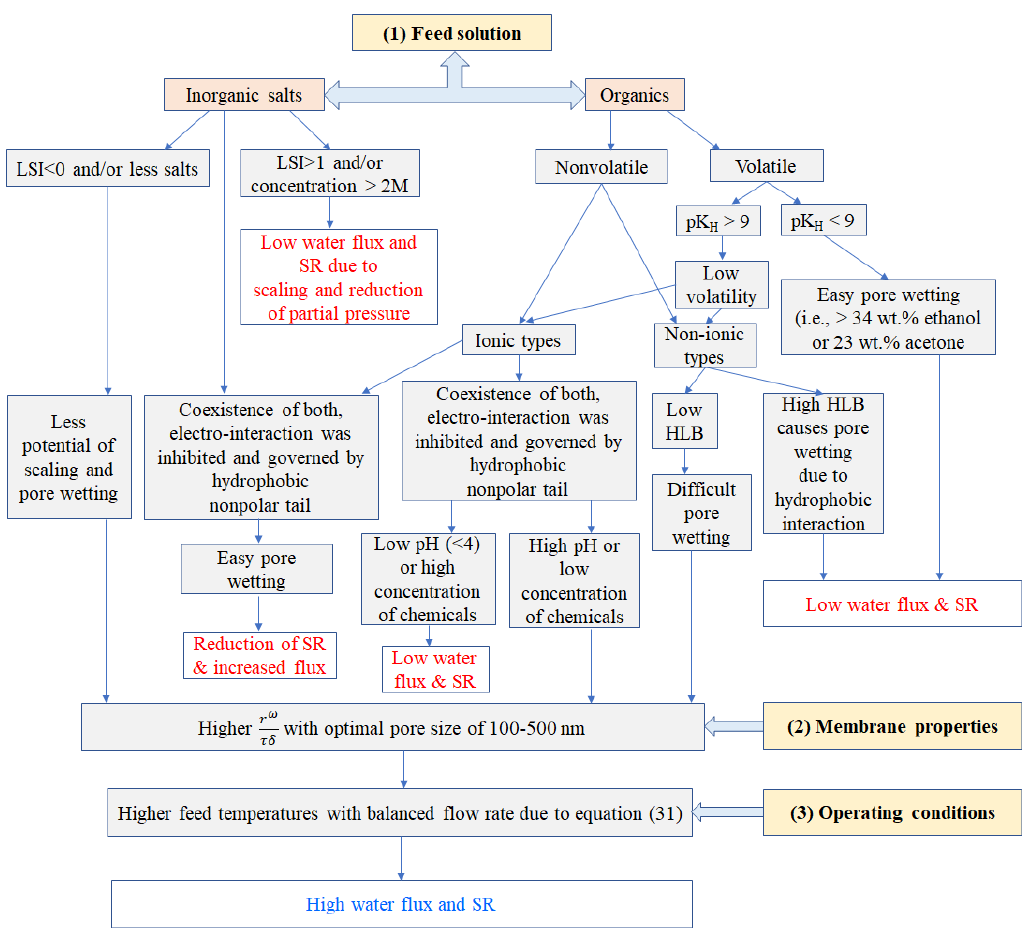
Figure 6. A diagram showing the interplay of factors affecting water flux and salt rejection in MD.